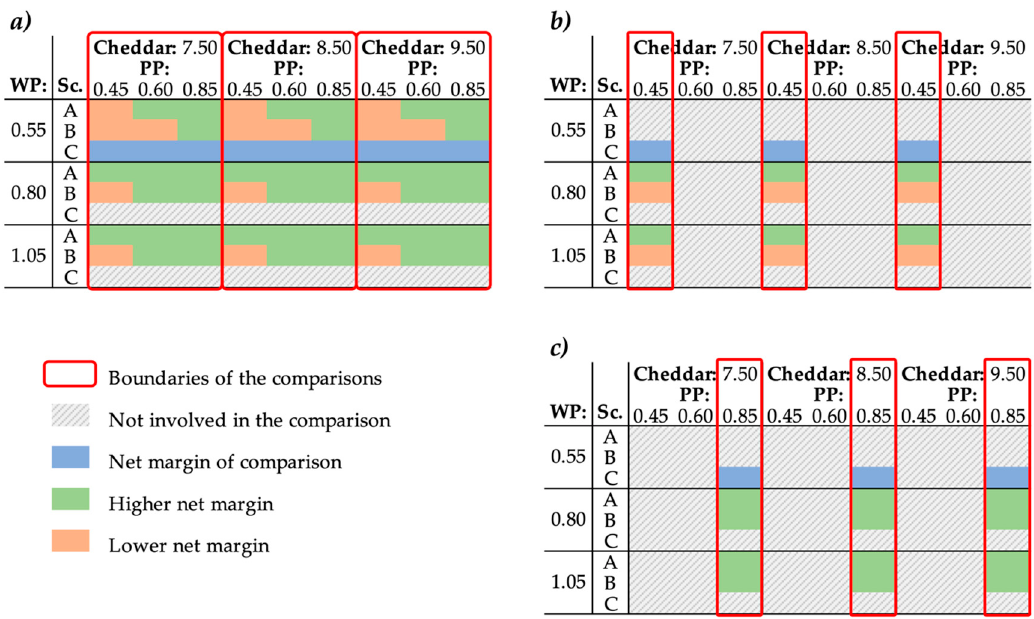
Bold values represent the most profitable (or the least detrimental) scenario for each economic condition.